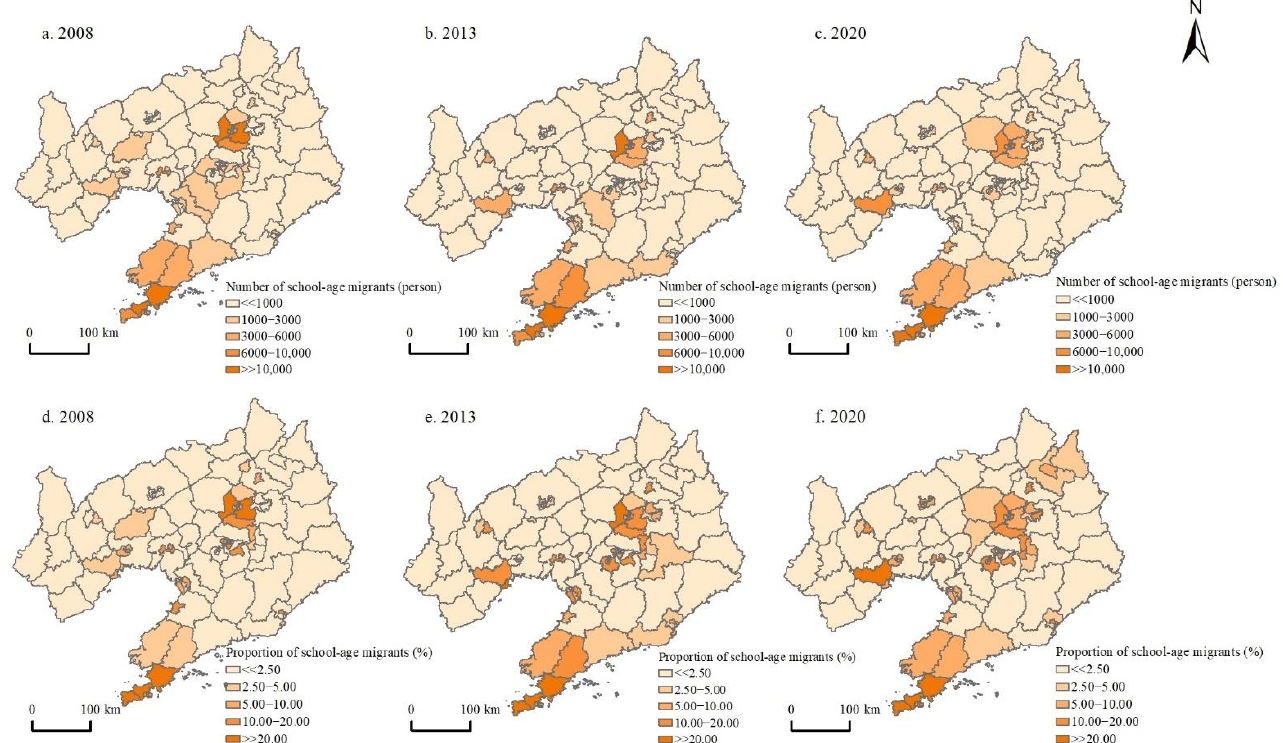
Figure 2. Spatial distribution of the school-age migrant population in Liaoning Province from 2008 to 2020: ( a – c ) number of school-age migrants and ( d – f ) proportion of school-age migrants.